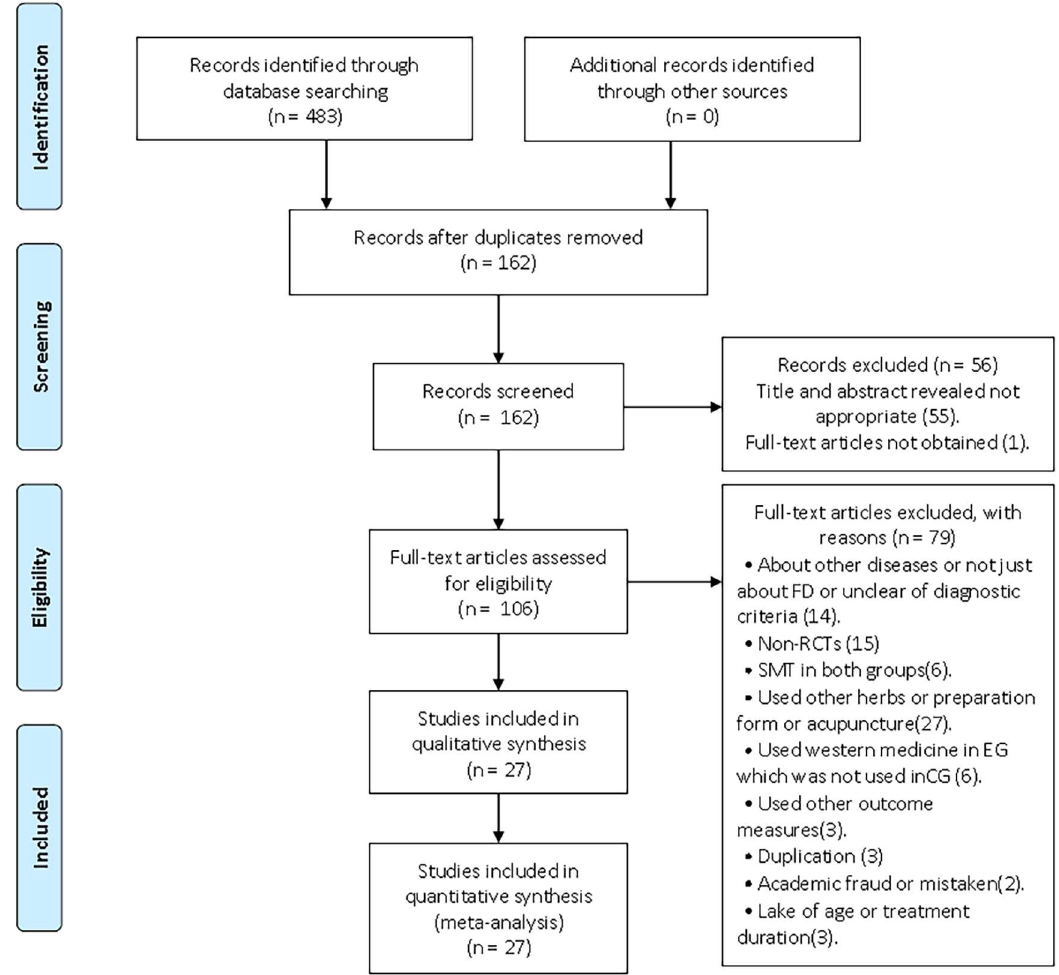
Fig 1. Flow chart of study selection process. PRISMA flow chart of the selectionprocess of SMT-treated FD. SMT = Si-Mo-Tangoral liquid, FD = functionaldyspepsia.